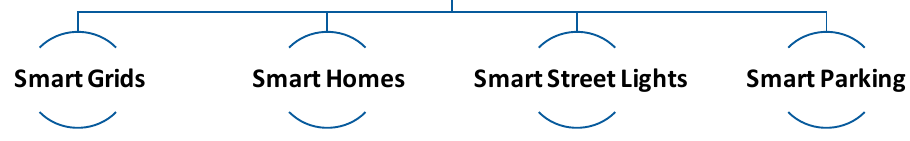
Figure 13. Conceptual model of a smart grid [130]. Researchers have broadened their focus to include the management of smart grids as a means of increasing energy efficiency. For example, Abbas et al. [124] provided a brief overview of challenges in smart cities using energy management in power